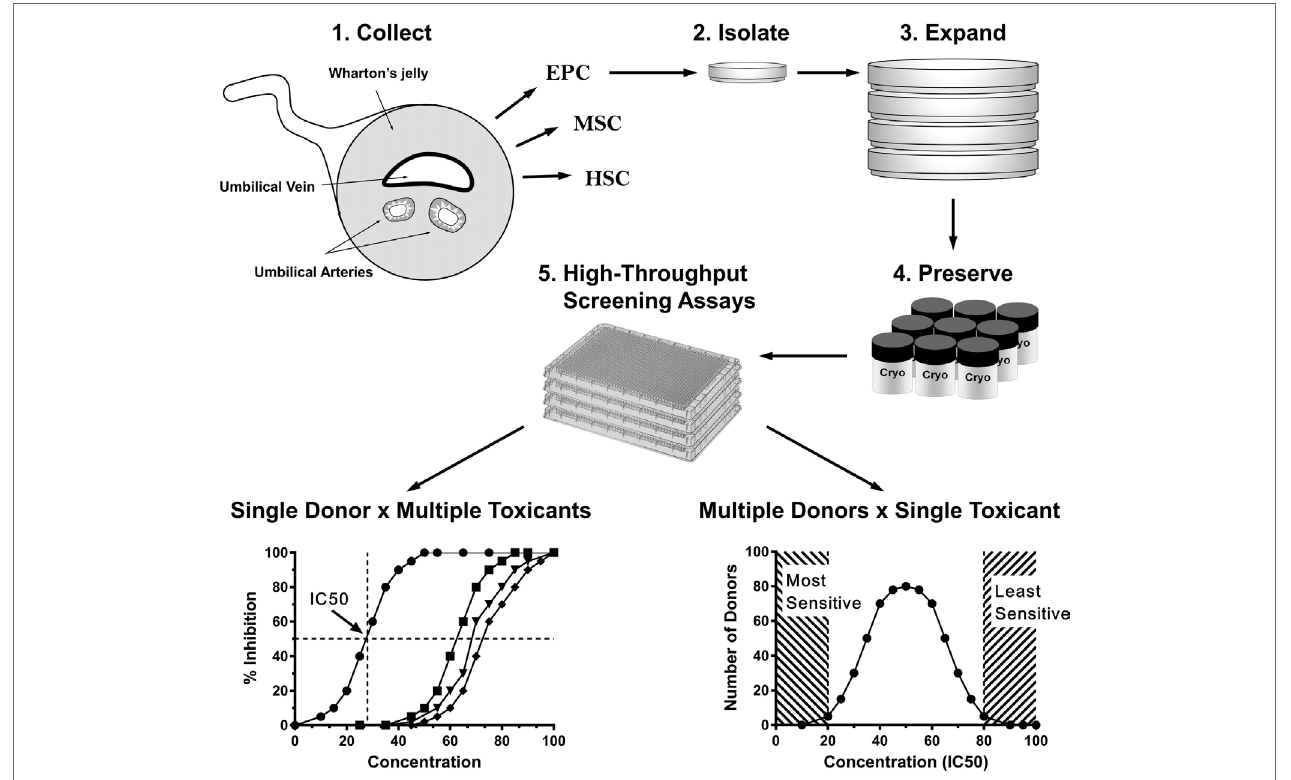
FiGURe 1 | Use of newborn stem/progenitor cells for assessment of individual and/or population-wide sensitivity to toxicants . Steps 1–4: a library of donor-specific cells can be used in a variety of high-throughput screening (HTS) assays depicted in Step 5. HTS assays provide information for either personal (lower left chart) or population-wide (lower right chart) toxicological assessment. Left chart shows dose-dependent inhibition of a cellular function (such as proliferation). Based on this curve, a chemical dose leading to 50% inhibition of a cellular function IC 50 is determined. Right chart shows a hypothetical distribution of cellular responses (IC 50 ) to a given toxicant. Dashed areas represent arbitrary thresholds for both most sensitive (left) and most resistant (right) phenotypes (individuals). HSCs, hematopoietic stem cells; MSCs, mesenchymal stem cells; EPCs, endothelial progenitor